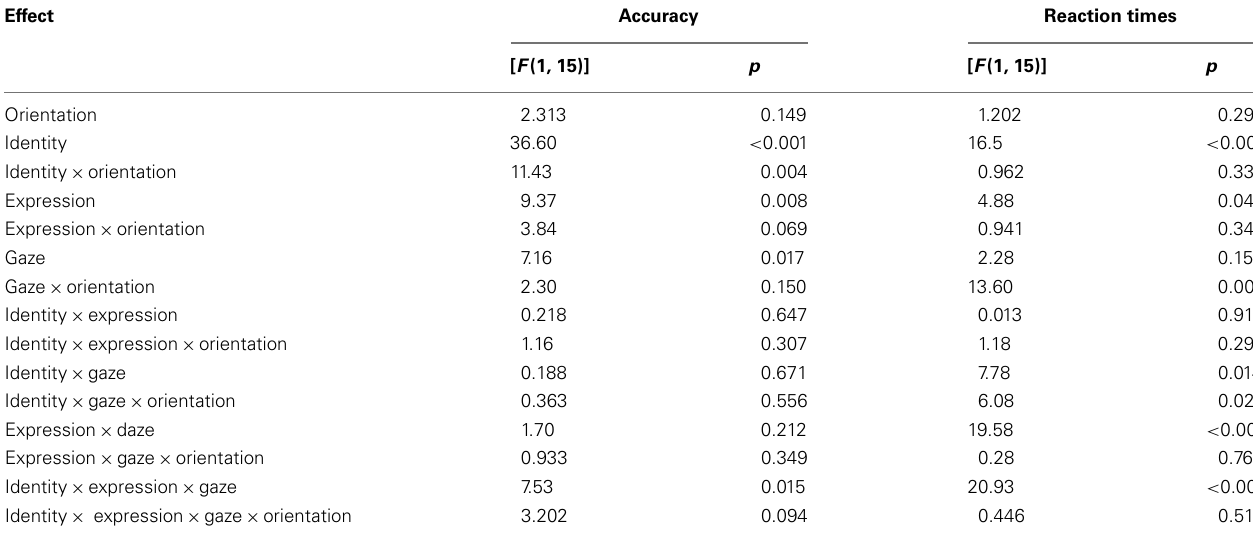
Table 2 | Experiment 1: main effects and interactions for the experimental factors identity × expression × gaze ×